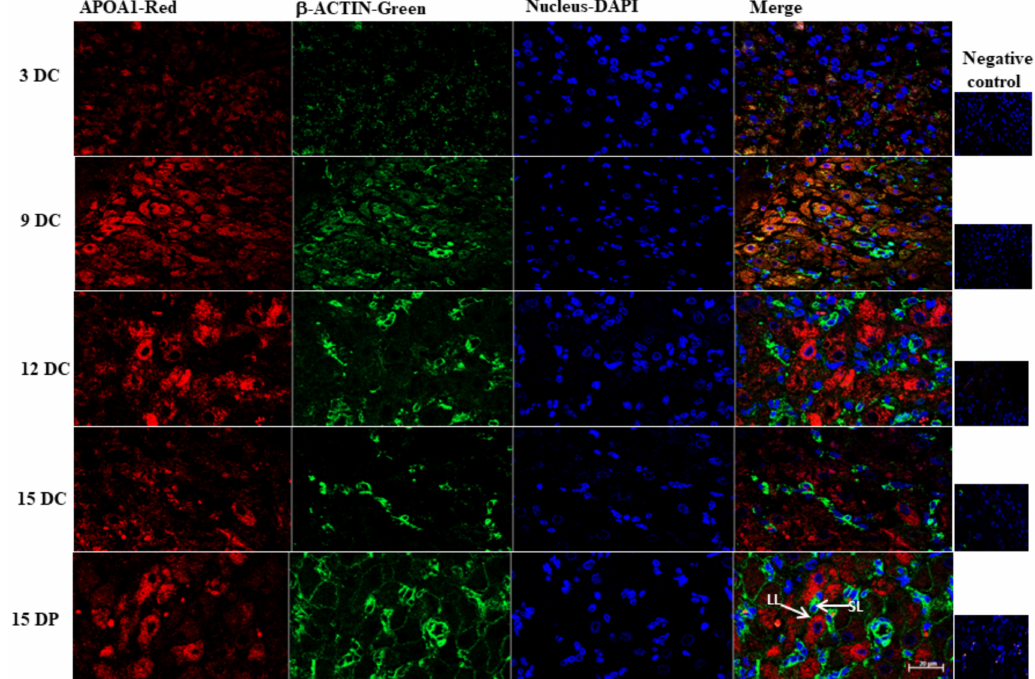
Figure 7. Localization of sterol transport protein in porcine corpus luteum. Representative confocal microscope images of immunofluorescent images of APOA on various days of the estrous cycle (DC) and Day 15 of pregnancy (DP). Maximum immunoreactivity of APOA1 was observed on 12 DC and 15 DP. LL—large luteal cells, SL—small luteal cells. Scale bar represents 20 µ